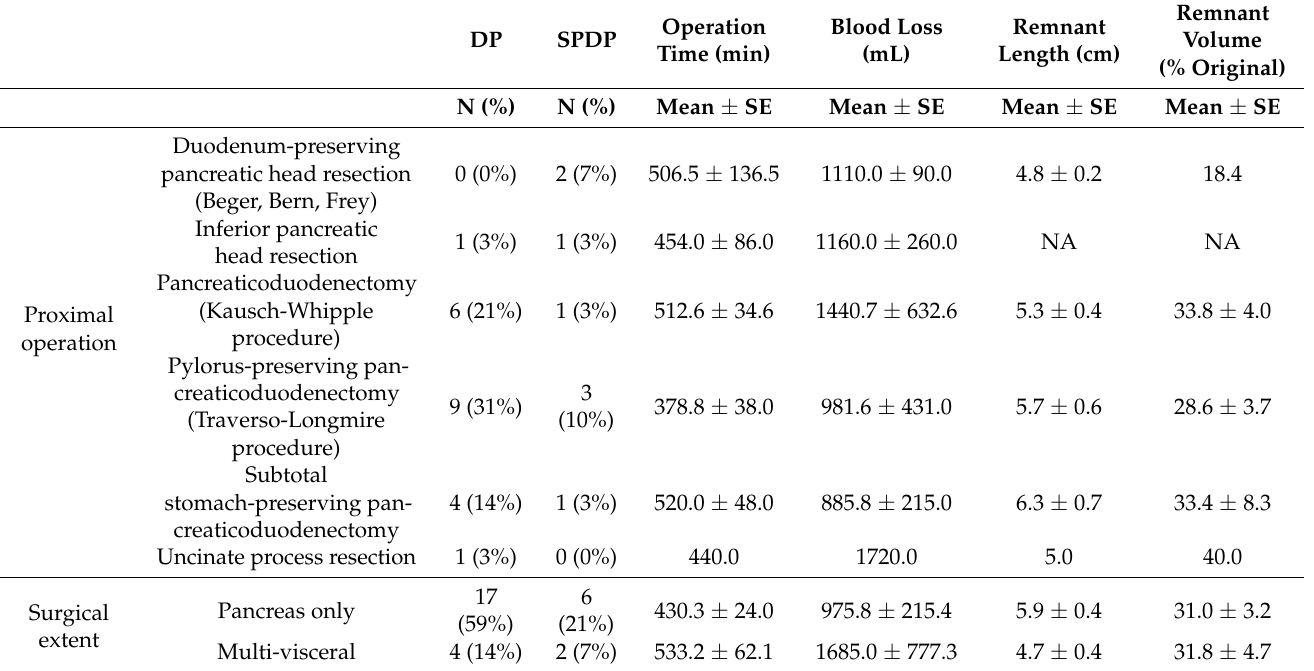
Table 2. Summary of intraoperative variables for MPP patients by proximal operation and surgical extent; frequency counts separated by use of spleen-resecting or -preserving procedures at the distal end.